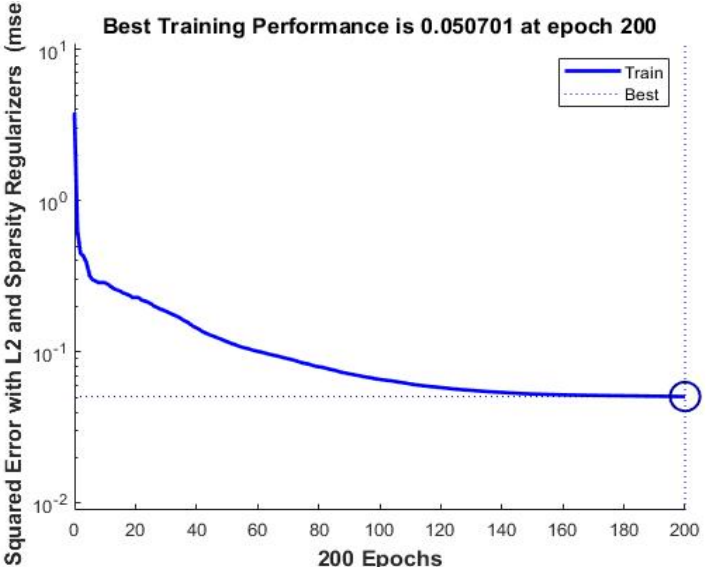
Figure 11. The learning curve for the proposed SSAE deep neural network for the OLR database.